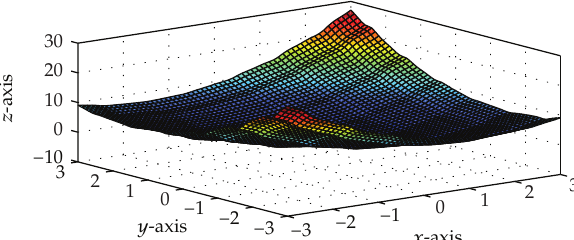
(cid:28) β j (cid:8) 4 , (cid:28) γ j (cid:8)